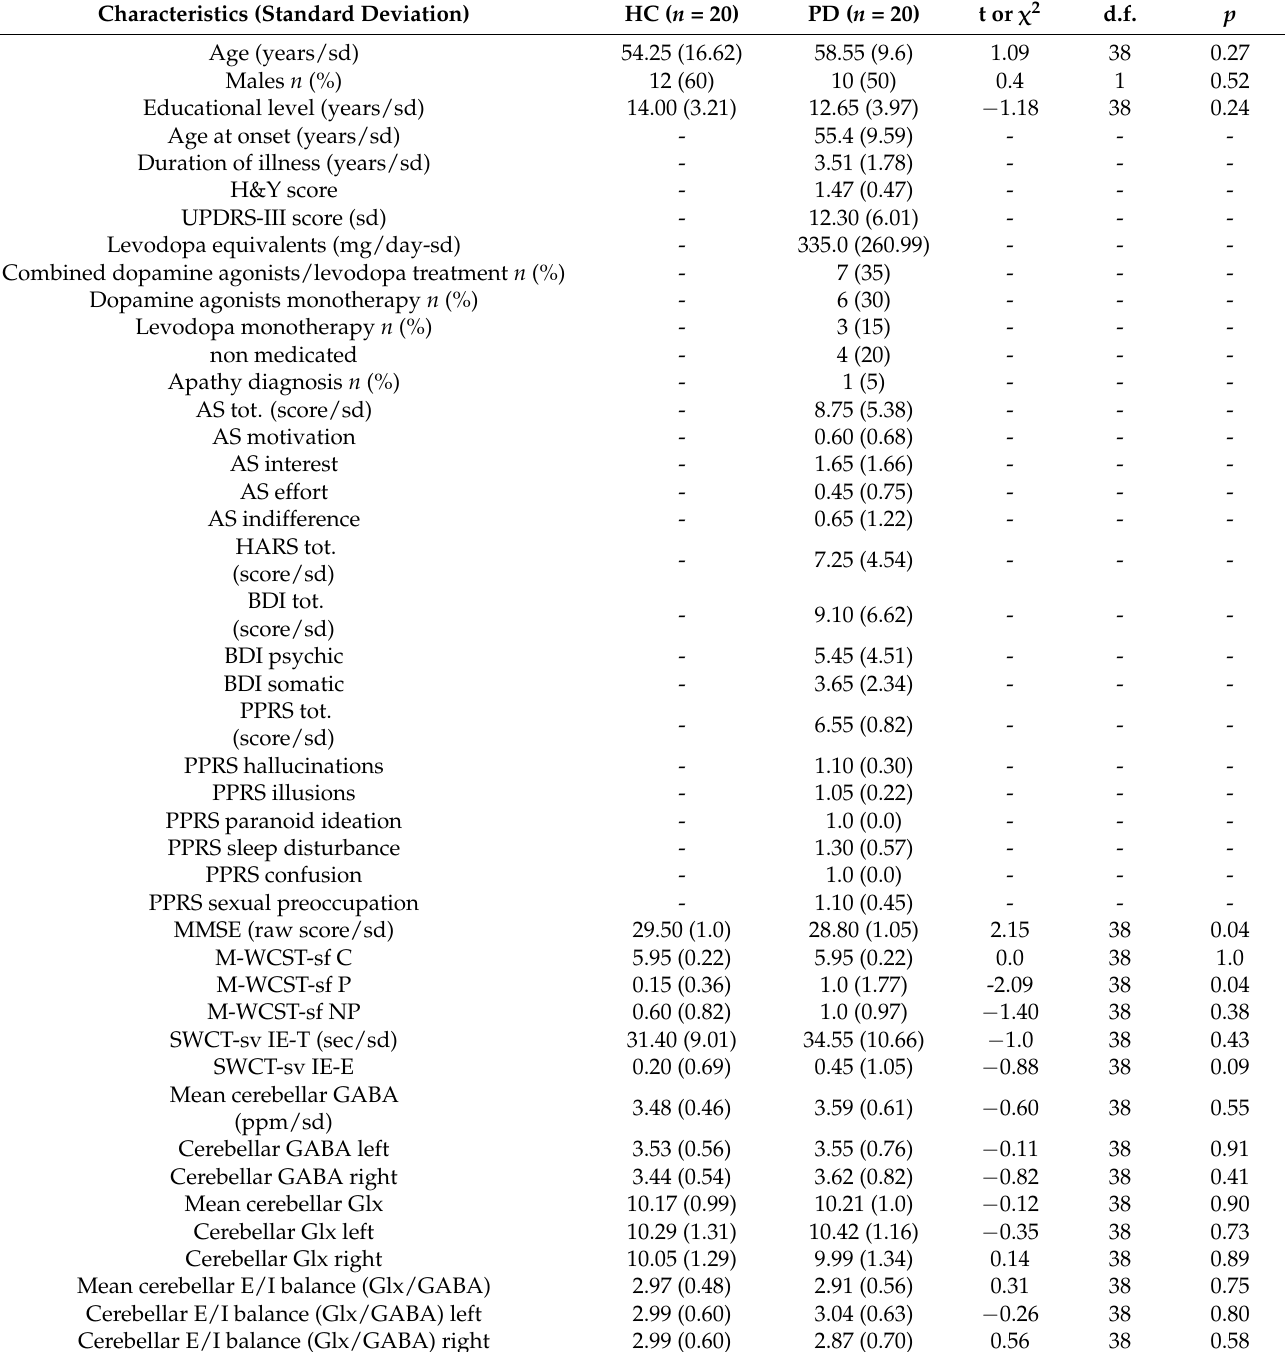
Table 1. Sociodemographic, clinical, psychopathological-cognitive characteristics, cerebellar GABA, Glx levels and excita- tion/inhibition balance in the studied